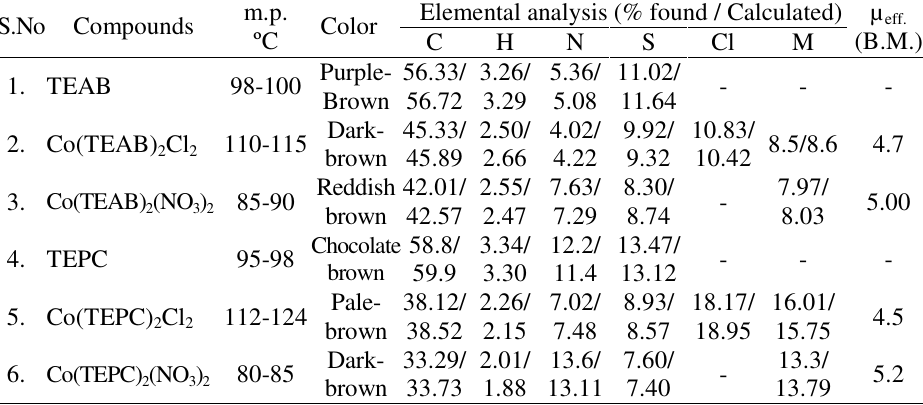
Table 1. Analytical, magnetic and physical properties of ligands and their Co(II) complexes. Elemental analysis (% found / Calculated) S.No